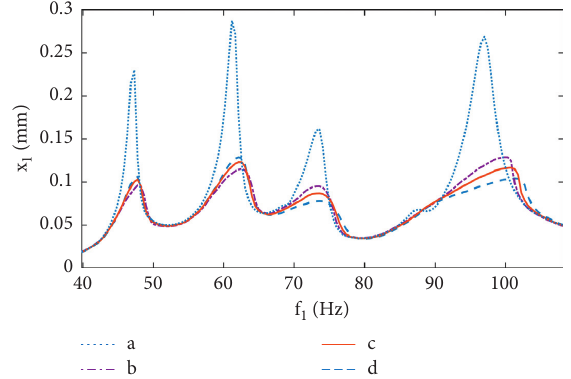
Figure 16: Amplitude-frequency curves when two SFDs are implemented on the rear bearing of the low-pressure shaft and the front bearing of the high-pressure shaft with different sets of clearances (a: no SFD, b: 0.22mm and 0.18 mm, c: 0.2 mm and 0.2mm, d: 0.18mm and 0.22mm).